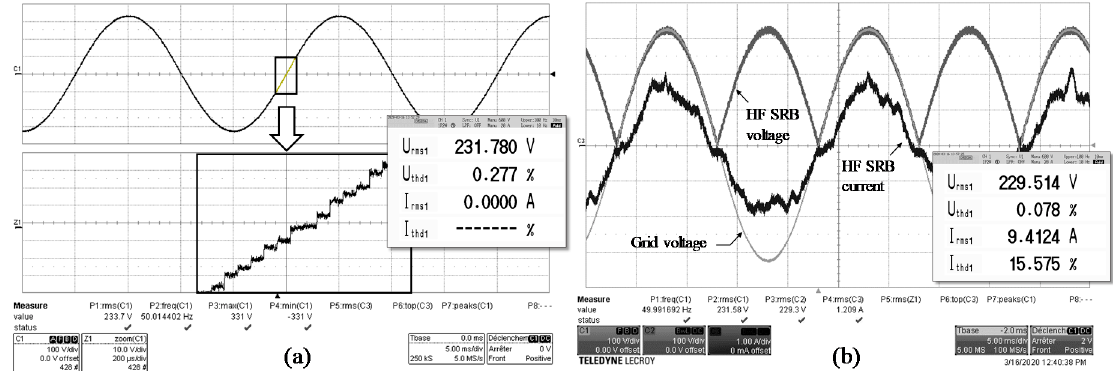
Figure 9. HF SRB 230Vac 50Hz experimental waveforms discharging on a resistive load ( a ) and direct charging on the electrical grid at 280 Wrms (b ).